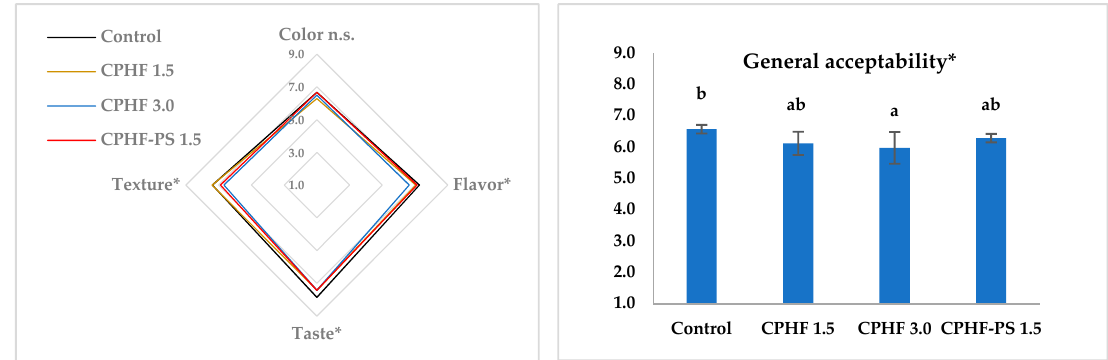
Figure 2. Spider diagram and column diagram of sensory evaluation of frankfurters samples with added cacao pod husk (control, CPHF 1.5%, CPHF 3.0%, and CPHF-PS 1.5%). Mean score of duplicate analysis ( n = 21). Letters different indicate significant differences (LSD test, p < 0.05). Asterisks indicate significance at * p < 0.05; n.s. not significant.